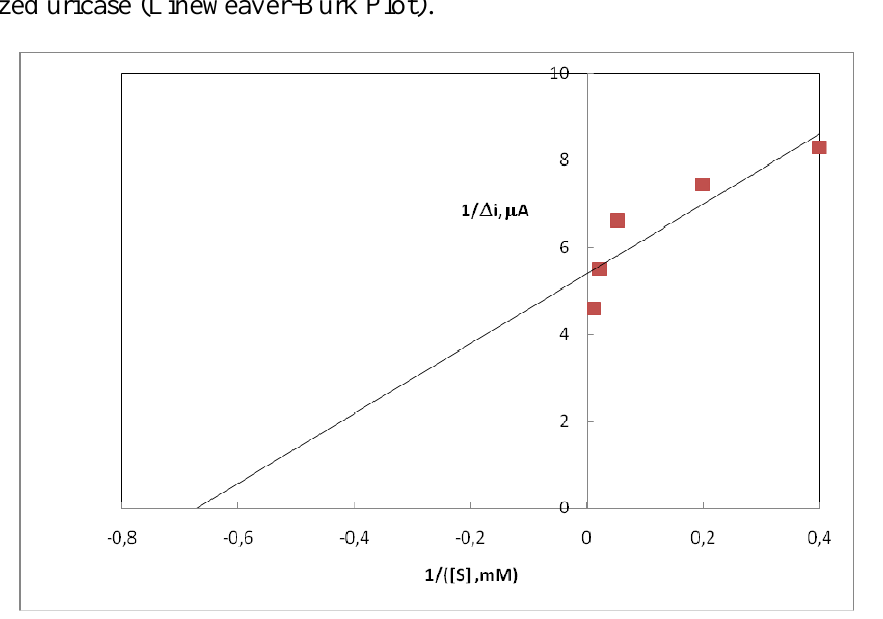
Figure 5. The effect of uric acid concentration upon the amperometric response of free and immobilized uricase (Lineweaver-Burk